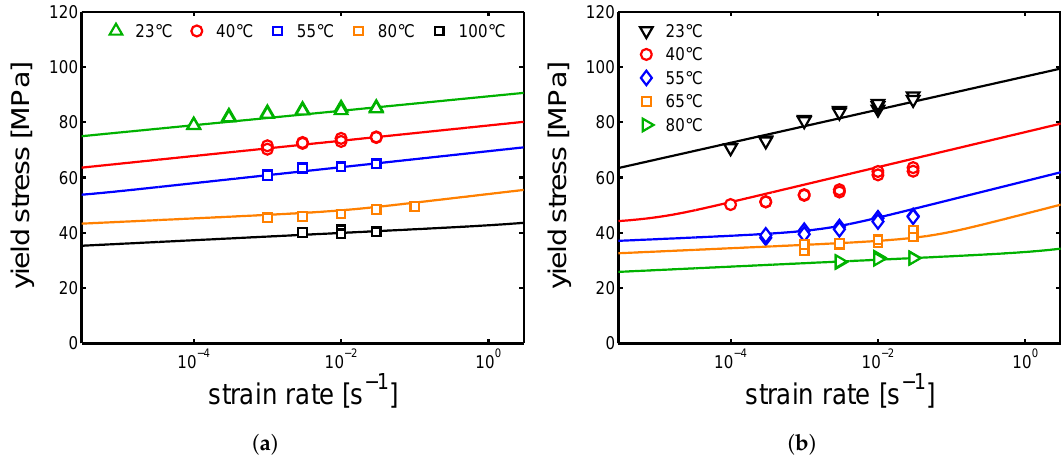
Figure 7. Stress–strain response at different temperatures (ranging from 23 °C to 100 °C) and a range of strain rate from 10 − 4 s − 1 up to 3 × 10 − 2 s − 1 for ( a ) α -I and ( b ) γ -I samples. Lines are the results of Equation (1).